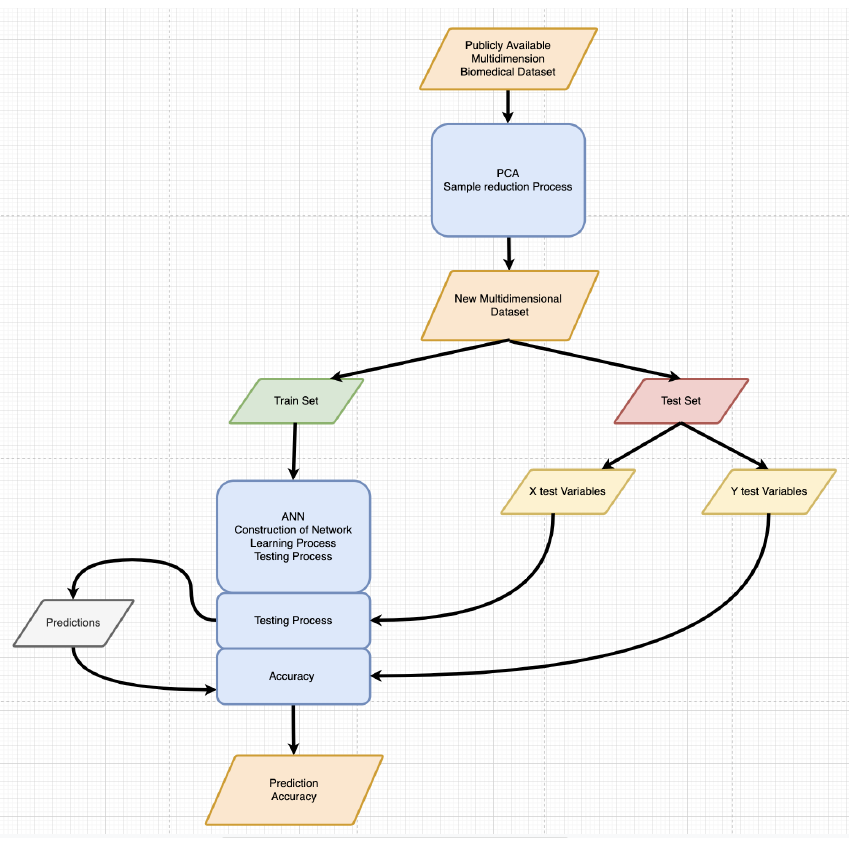
Figure 11. Pre-processing an application of multidimensional datasets in the proposed approach.